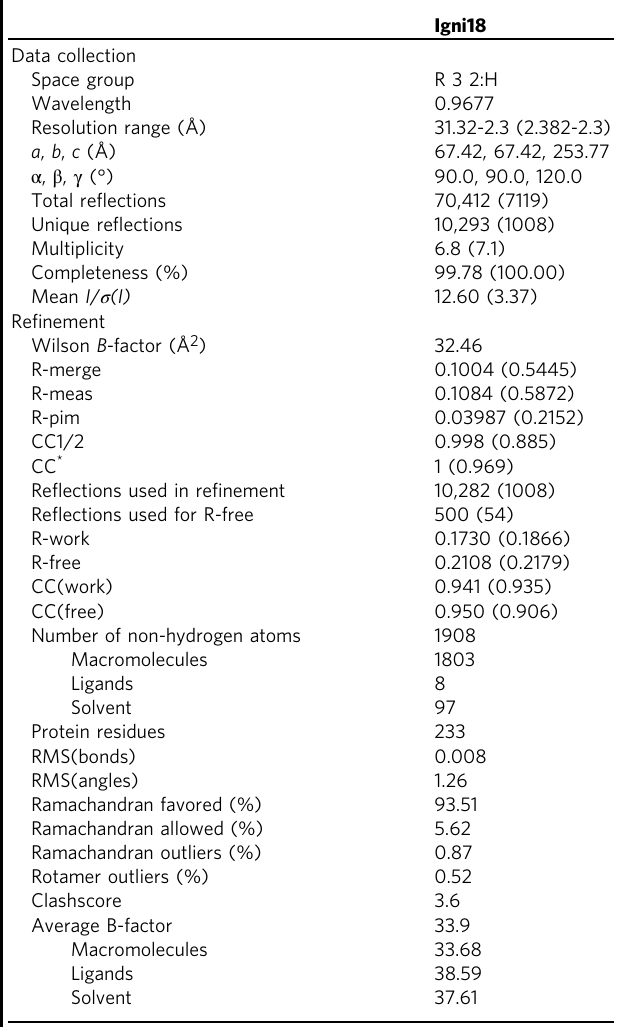
Table 1 Data collection and re fi nement statistics (molecular